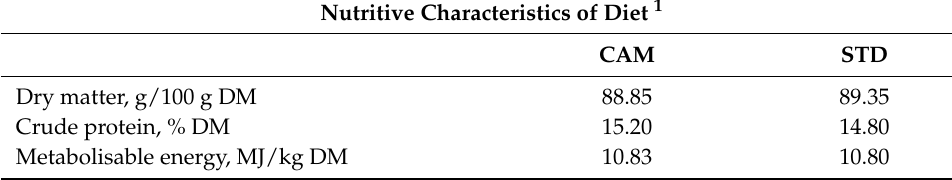
Table 2. Nutritive characteristics of two rations (pellets) used for the 8 weeks feeding of maternal Composite lambs and Merino